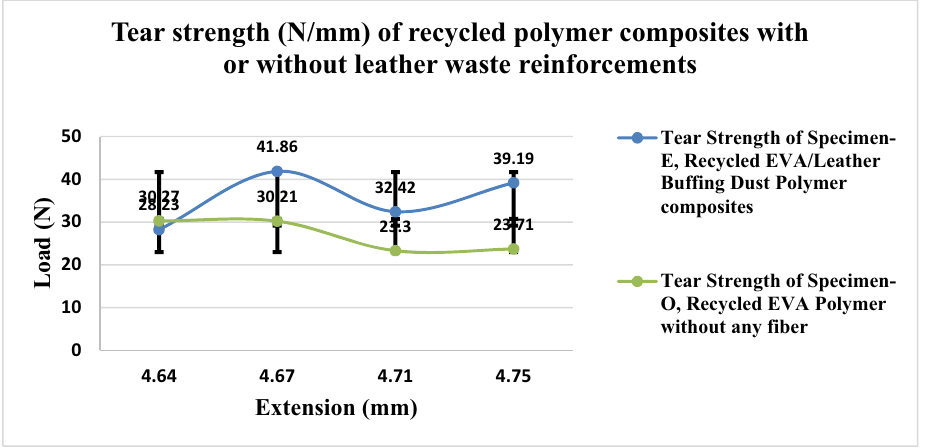
Figure 36: Variation of tear load ( N ) against extension ( mm ) of recycled EVA polymer composites with or without leather bu ffi ng dust.